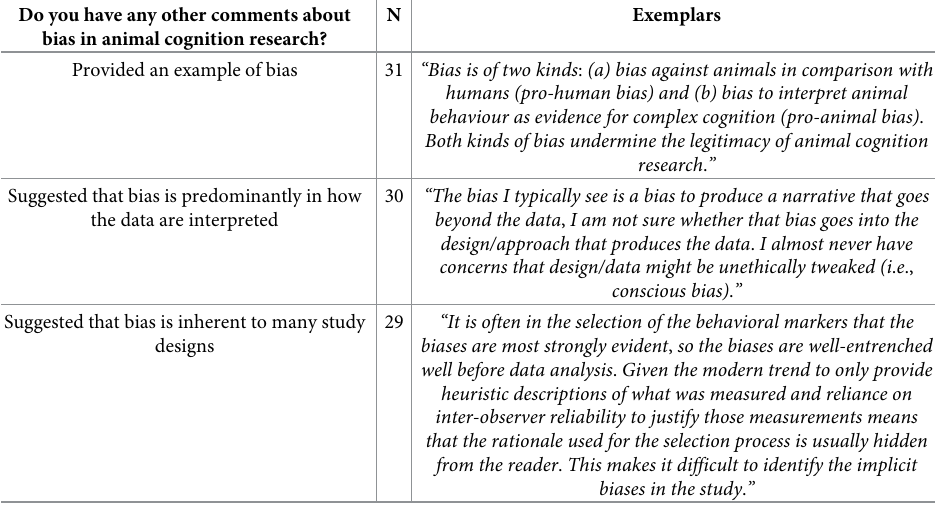
Table 2. Animal cognition researchers’ beliefs about bias in animal cognition research. Do you have any other comments about bias in animal cognition